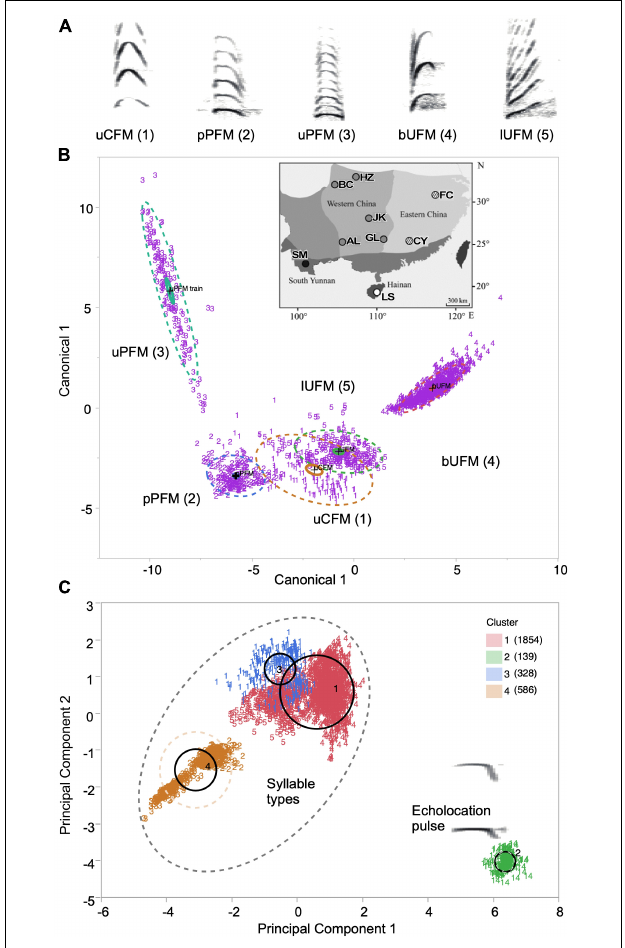
FIGURE 1 | (A) Spectrographic patterns plotted to scale and labeled by name and marker (in parenthesis as used in B ) for each syllable. (B) Scatterplot of the first two canonical variables capturing the multiparametric variation for each of the five syllable types recorded for all locations within the South China region. The discriminant analysis tested for misclassification of observations for the syllable types. The point corresponding to each multivariate mean is denoted by a plus (“+”) marker. Bold lines denote the 95% confidence ellipses and dashed lines indicate boundaries containing ∼ 50% of the observations. Inset: Map of geographic locations of different habitats from where sound recordings were obtained from different bat populations. (C) A scatterplot of the first two principal components from a K-means cluster analysis of acoustic parameters in the five syllable types and echolocation pulses. A best fit was obtained for the four color-coded clusters shown (numbers in parentheses in the key indicate syllable count in each cluster). Numbers as marker labels represent different syllable types illustrated by their spectrograms. Cluster 2 (green) was made up entirely of echolocation pulses, whereas clusters 1, 3, and 4 represent the five syllable types within social vocalizations. The scatterplots indicate the larger variation captured by each syllable cluster compared to the pulses and also the relatively large distance in multivariate acoustic space between acoustic characteristics of pulses vs. syllables. Centroids for each cluster are indicated by bold ellipses and dashed lines represent boundaries of 50% confidence ellipses. Numbers in parenthesis in the legend indicate the number of observations placed within each cluster. Numbers as marker labels correspond to each syllable type (“1” to “5” and “14” for echolocation pulse). A spectrographic plot of the echolocation pulse is also